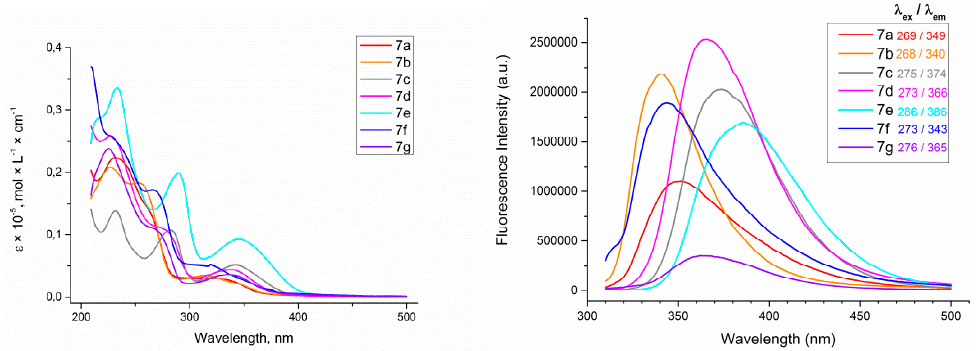
Figure 3. Absorption spectra of 4-azidocinnolines 7a − g solutions in THF, C = 1 × 10 -5 mol/L (left) and emission spectra of 4-azidocinnolines 7a − g solutions in THF, C = 0.33 × 10 -5 mol/L (right). Table 1. Absolute QY for THF solutions of 6-aryl-4-azifocinnolines 7a − g .